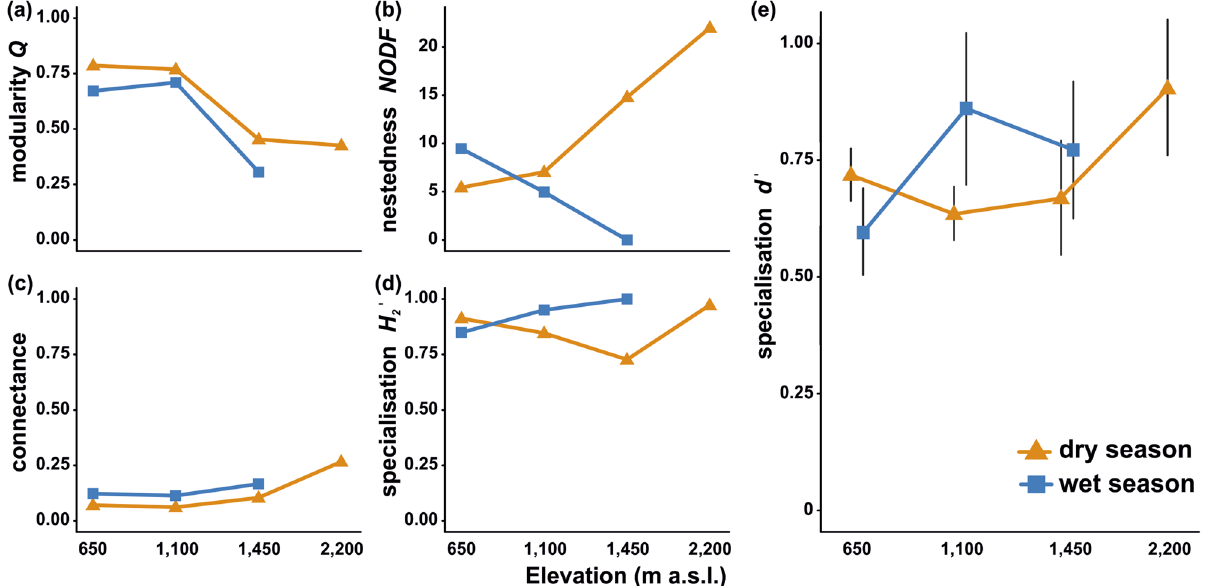
Figure 3. Metrics of plant-lepidopteran networks on Mount Cameroon, comparatively for each elevation and season. The symbols depict arithmetic means in all plots, whilst error bars in (e) represent 95% confidence intervals.